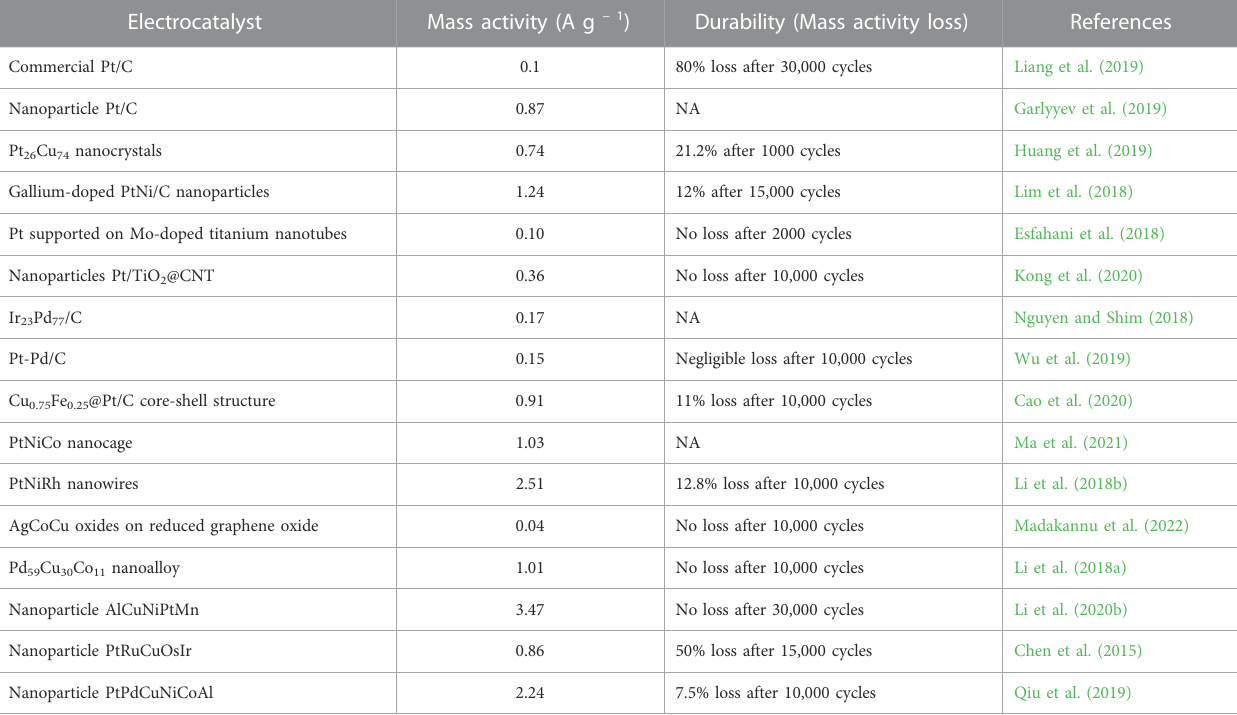
TABLE 2 Activities and durabilities of different